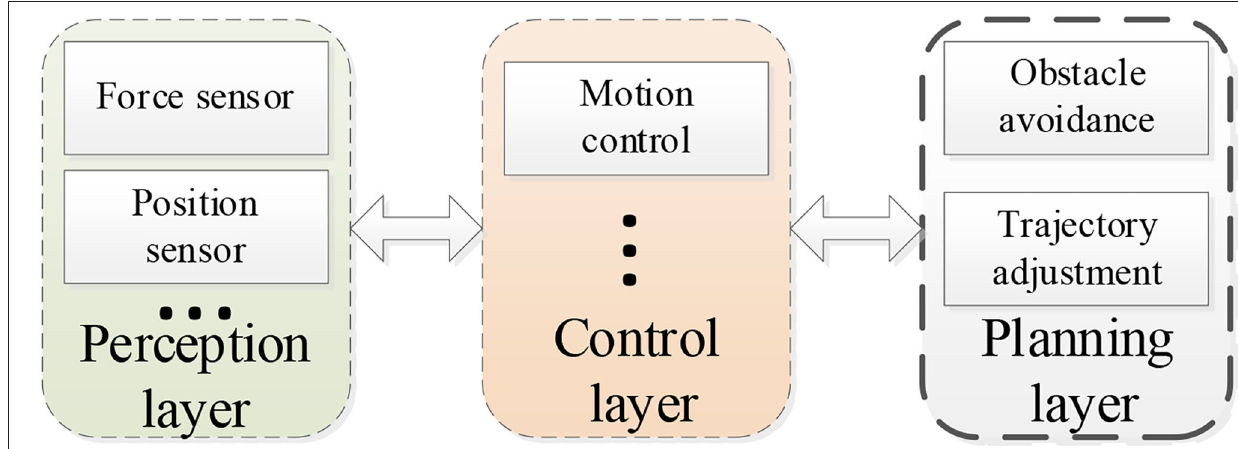
FIGURE 1 | Hierarchical structure of the robot system.